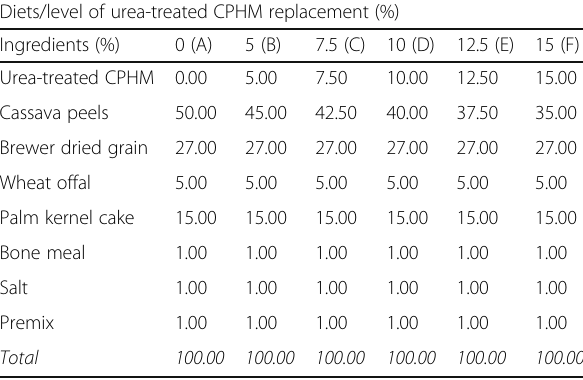
Table 1 Gross composition of graded inclusion levels of urea-treated CPHM in complete concentrate diets Diets/level of urea-treated CPHM replacement (%) Ingredients (%) Urea-treated CPHM